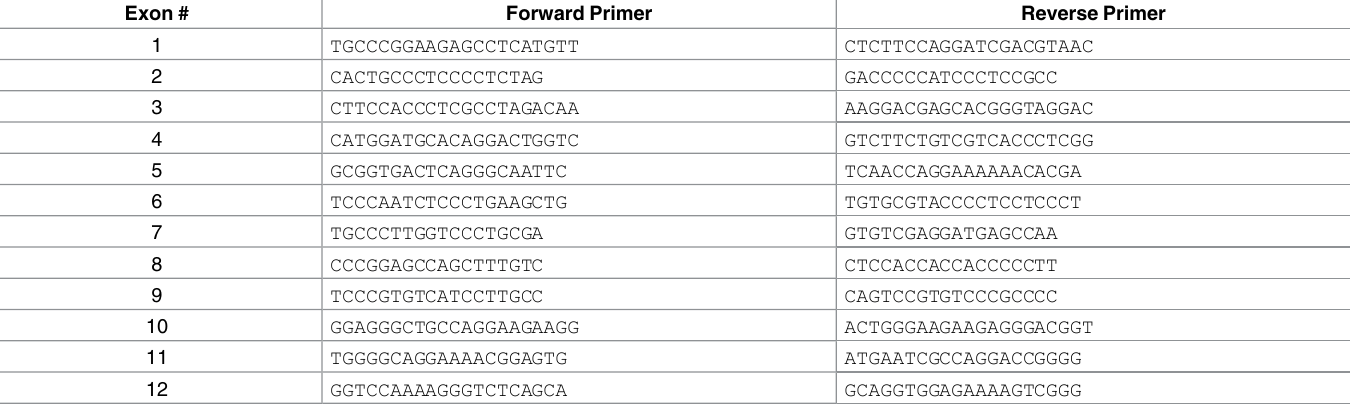
Table 2. Sequence of primers used to amplify exons and exon-intron boundaries of CETP gene. Annealing temperatureof all the 12 set of primers are